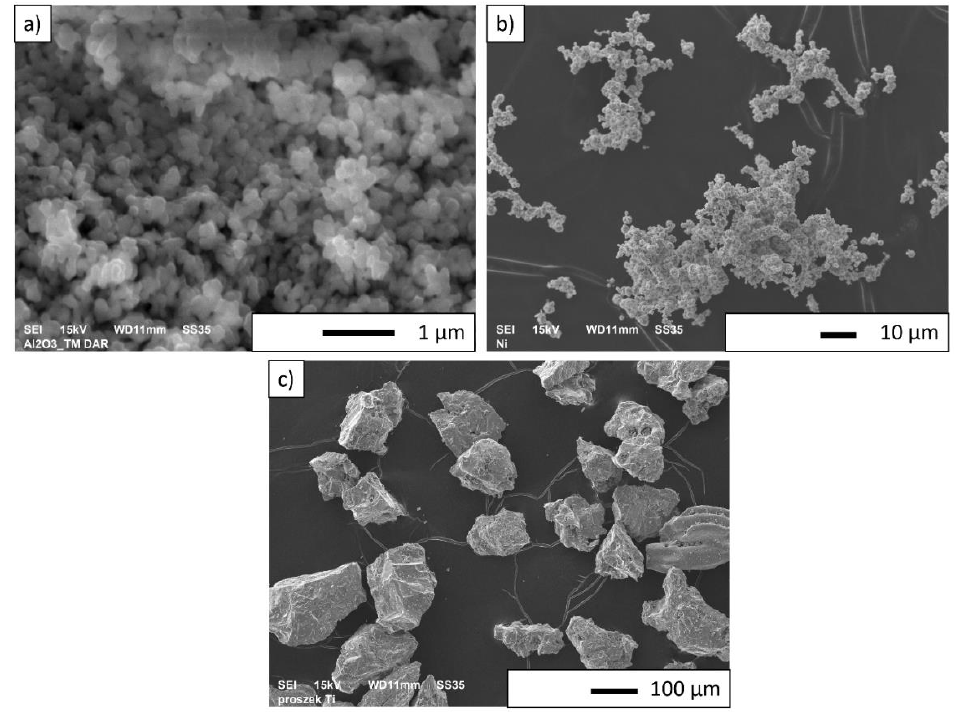
Figure 2. Sample SEM photos of Al 2 O 3 ( a ), Ni ( b ) and Ti ( c ) powder. Then, as a result of laser particle size measurement, a distribution was obtained, which represents the volume percentage of individual fractions with a given particle diameter of Al 2 O 3 , Ni and Ti in the total volume of powders. Figure 3a–c show the results obtained. The average particle size of the alumina powder (Figure 3a) obtained during the test is equal to 0.61 µ m, and the median is 0.48 µ m. The particle diameter range of PSD distribution is very wide, ranging from 0.17 µ m to 7.69 µ m. The most abundant fraction of 17.24% of the powder volume are particles with a diameter of 0.51 µ m. The obtained results differ from the average particle size declared by the manufacturer. This is due to the fact that alumina powder is prone to form an agglomerate formation, which has been confirmed by SEM observations. Figure 3b shows the results for the nickel powder. The mean particle size of the nickel powder obtained during the test is 35.888 µ m and the median 22.86 µ m. The particle diameter range of the PSD distribution is bimodal and ranges from 3.41 µ m to 262.38 µ m. The analysis revealed the presence of two powder fractions ranging from 3.409 µ m to 26.11 µ m and from 26.11 µ m to 262.38 µ m. In the case of the first fraction, the particles with a diameter of 13.25 µ m represent the largest batch of 6.005% of the powder volume. In the case of the second fraction, the largest batch of 4.98% of the powder volume are particles with a diameter of 51.47 µ m. The obtained results differ slightly from the mean particle size declared by the manufacturer < 50 µ m. The test shows that the average particle size of the nickel particles is about 35 µ m, however, there are also particles larger than 50 µ m. Figure 3c shows the results for the titanium powder. The mean particle size of the titanium powder obtained during the test is 57.89 µ m, and the median is 53.46 µ m. The particle diameter range of the PSD distribution is wide, ranging from 11.57 µ m to 262.38 µ m. The most abundant fraction of 12.40% of the powder volume are particles with a diameter of 58.95 µm.